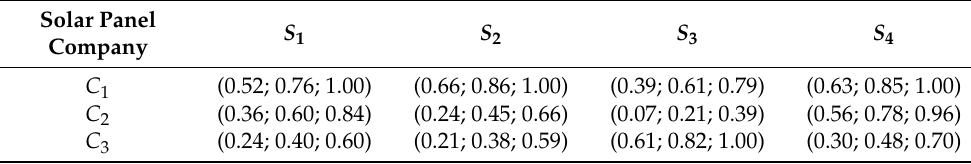
Table 13. Fuzzy normalized decision matrix for M 2 .